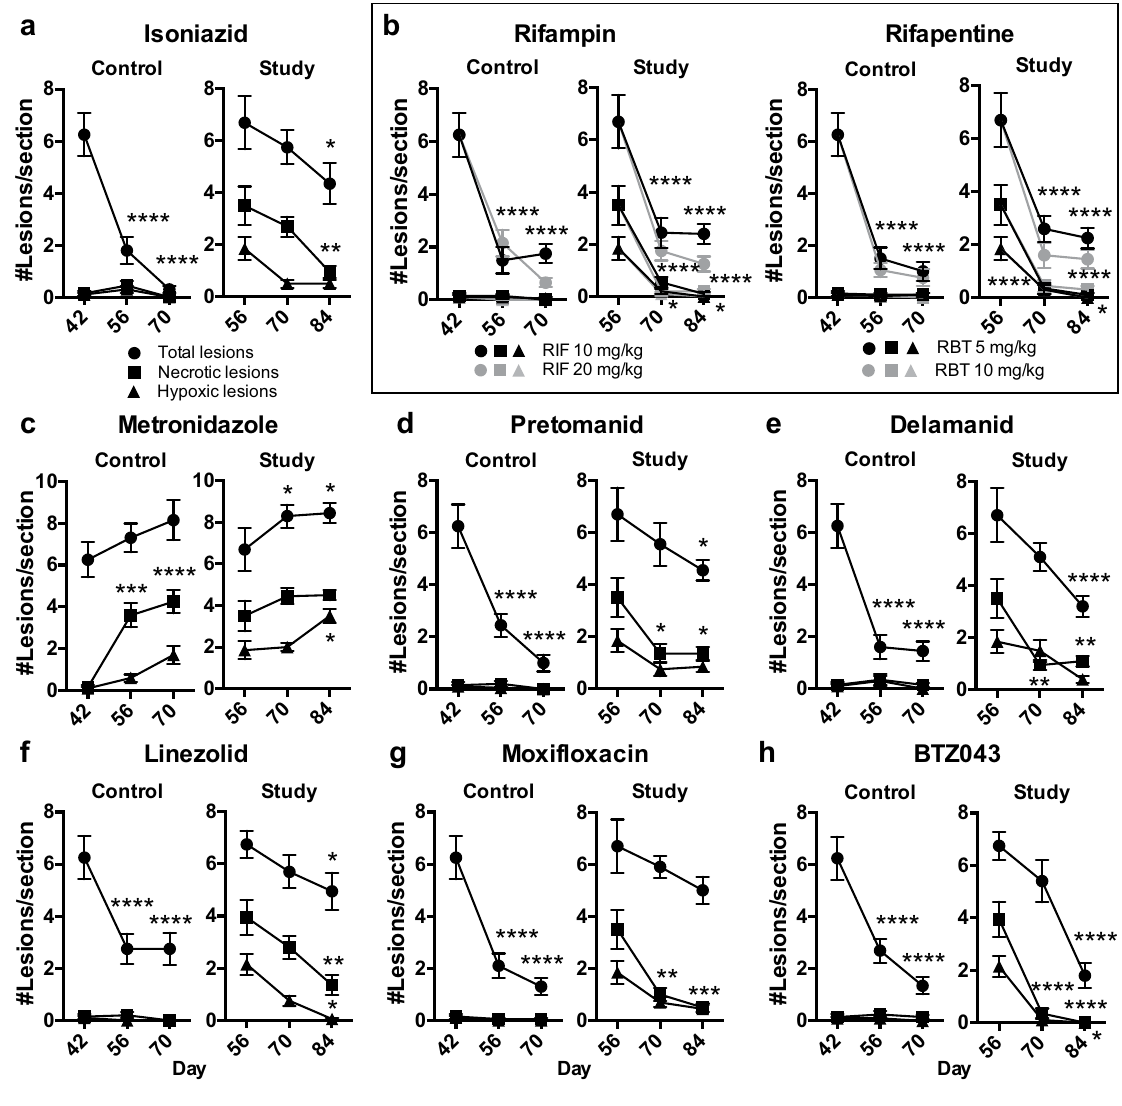
Figure 4. Impact of monotherapy on pulmonary pathology in Nos2 − / − mice with TB. Monotherapy for